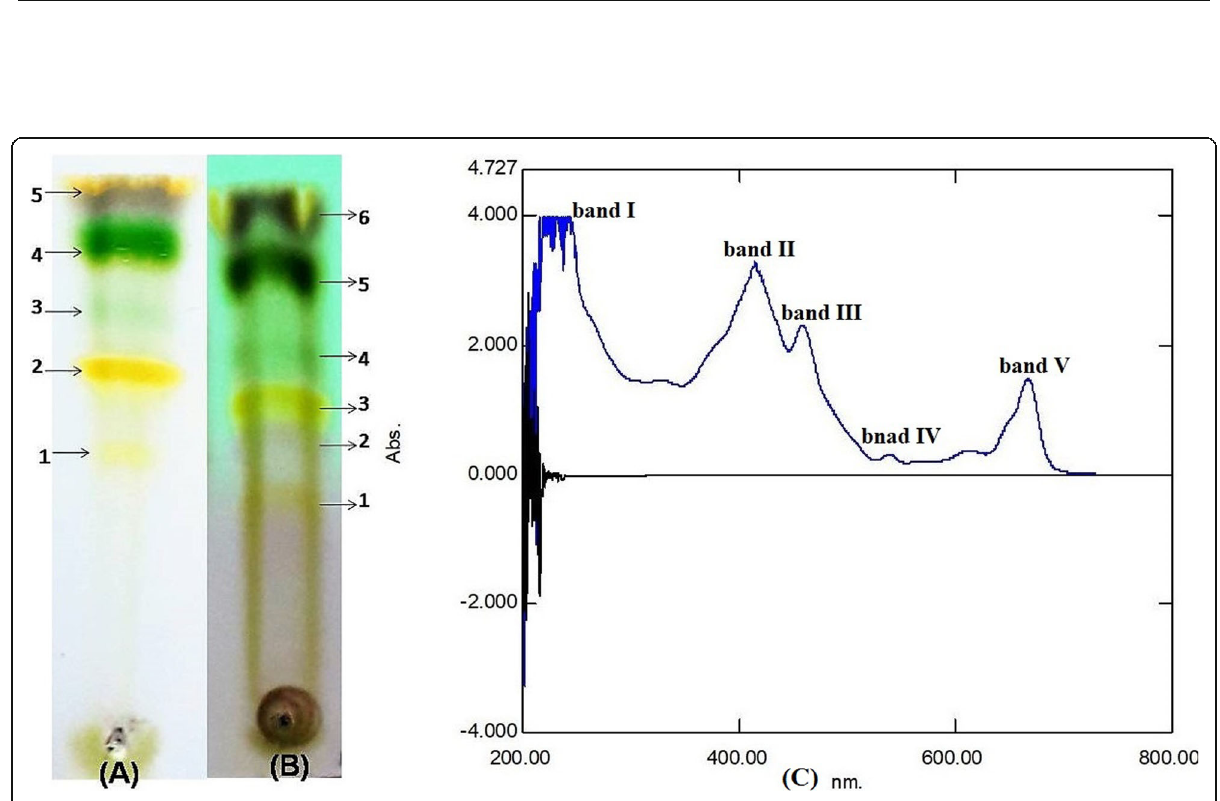
Fig. 2 Thin-layer chromatograph of chloroform extracts of Andrographis paniculata whole plant. a Visualization in visible regions. b Visualization in UV-regions (254 nm). c UV-visible spectrum of chloroform extract of Andrographis paniculata whole